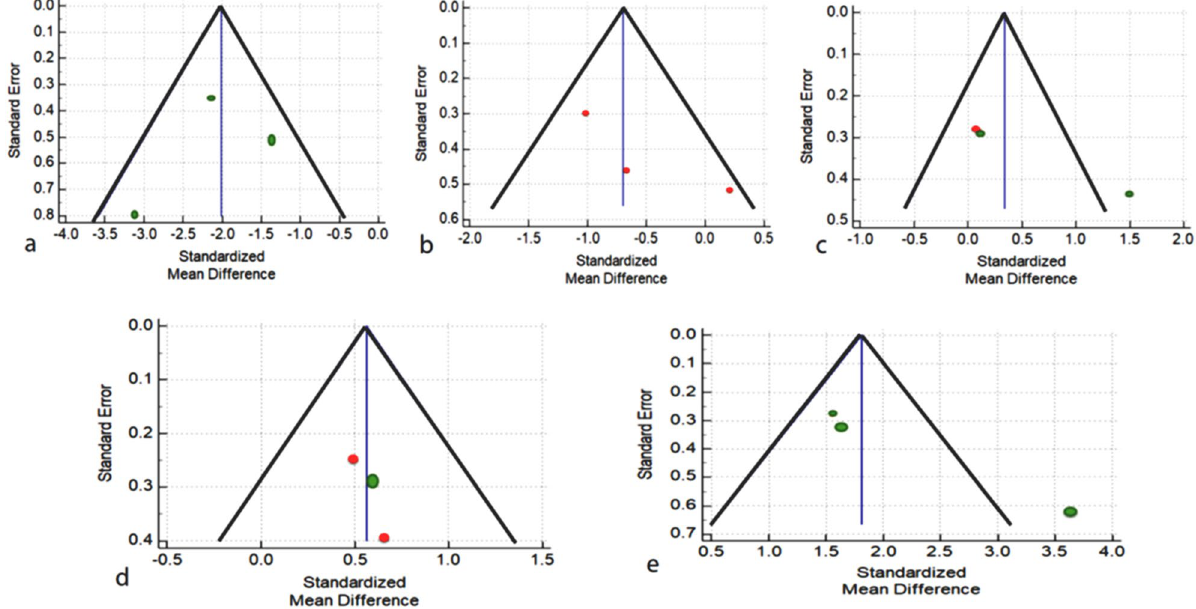
Figure 10. Funnel plot for the outcome of ( a ) SNA, ( b ) SNB, ( c ) PPR-S-PPL, ( d ) N-S-PP, and ( e ) greater wing